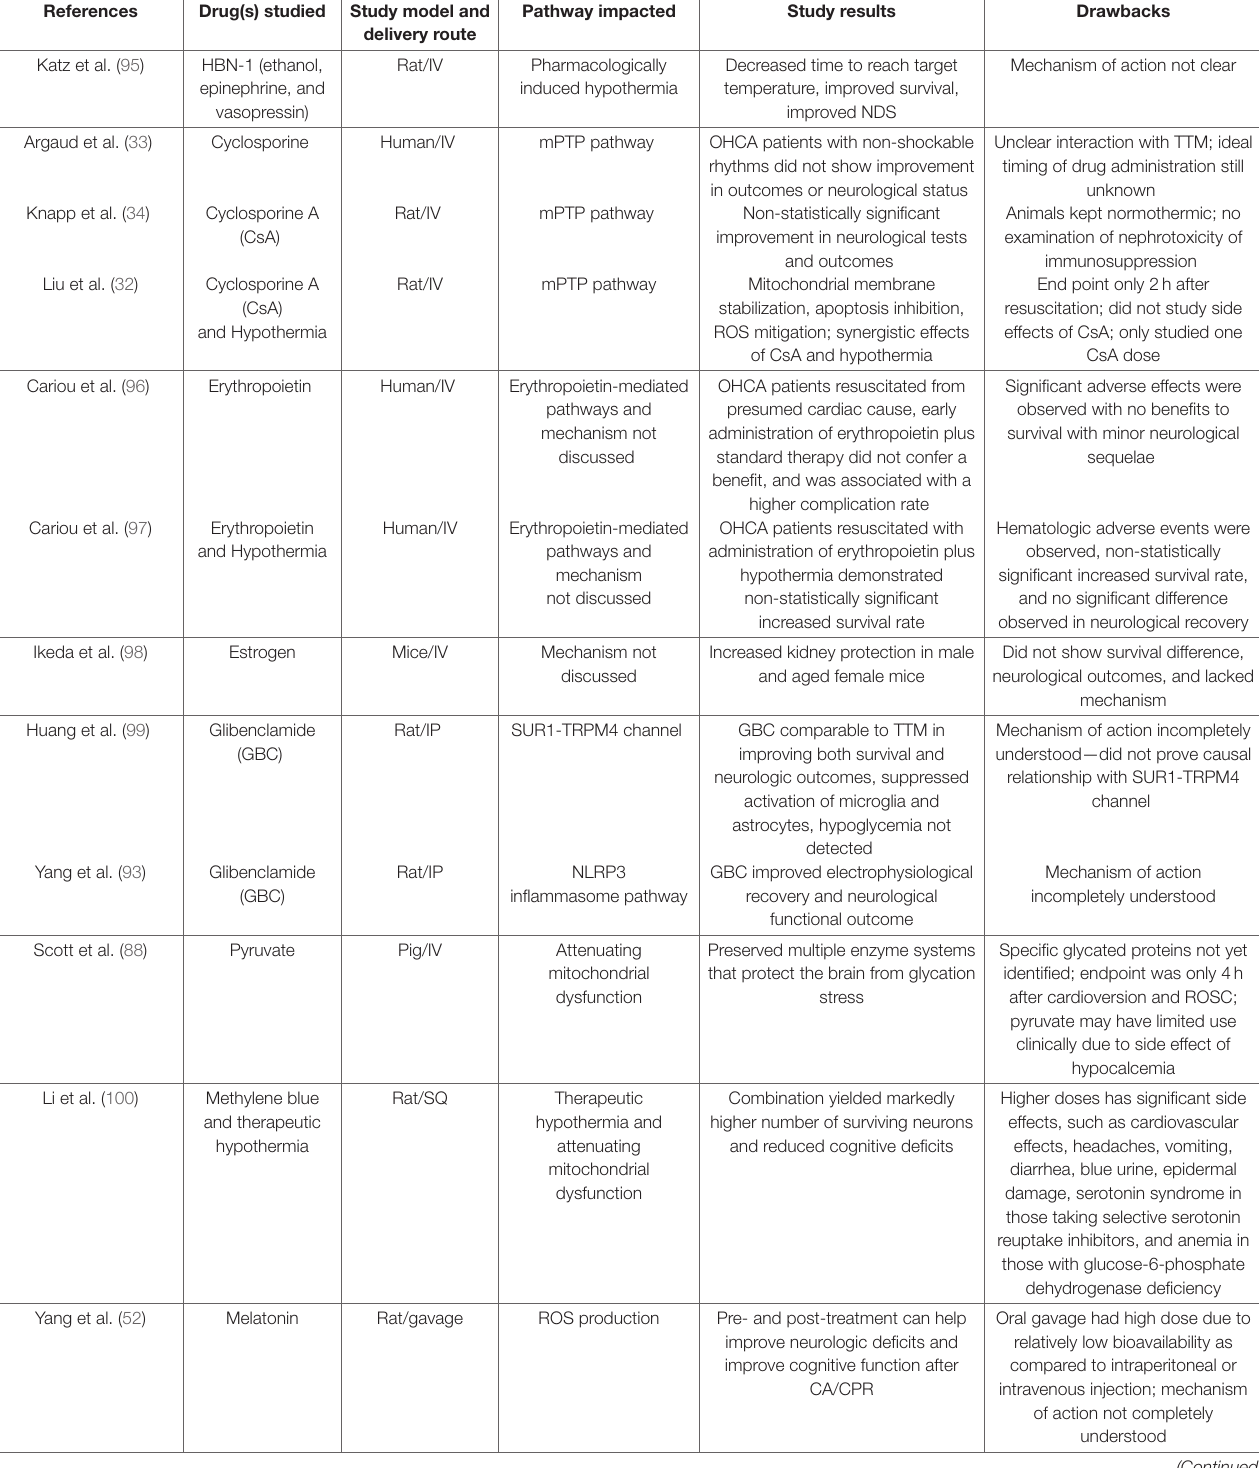
TABLE 1 | Pharmacological interventions with their study results, mechanisms of action, and potential drawbacks for conferring survival and neuroprotection after cardiac